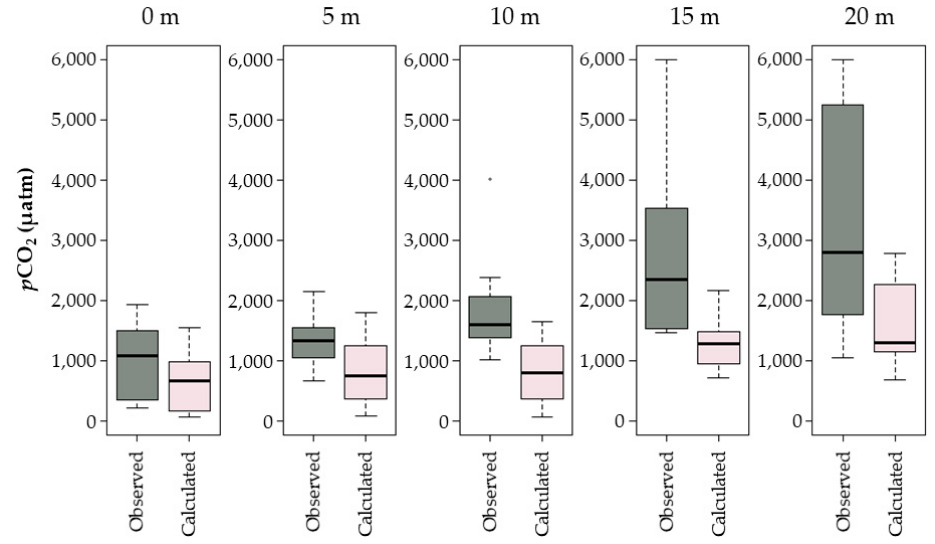
Figure 4. Box plot comparisons of observed (nondispersive infrared method) and calculated (pH/Alk method using CO2SYS) p CO 2 by depth (0, 5, 10, 15, and 20 m).